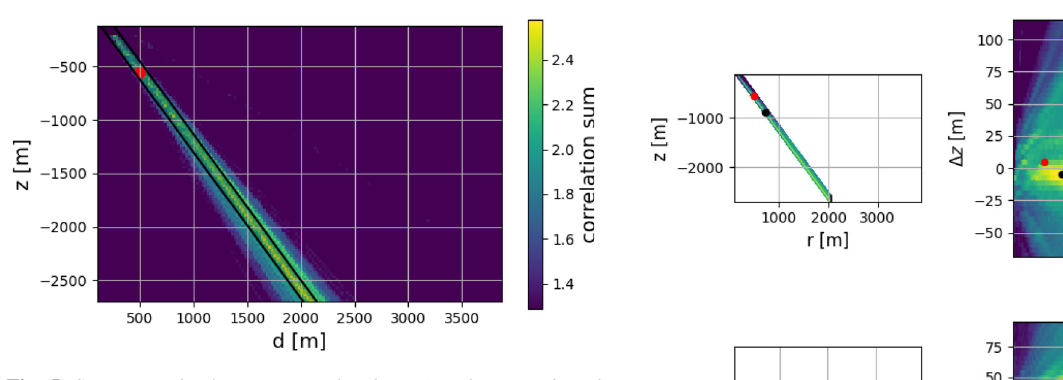
but we again only show the projection onto the horizontal distance r